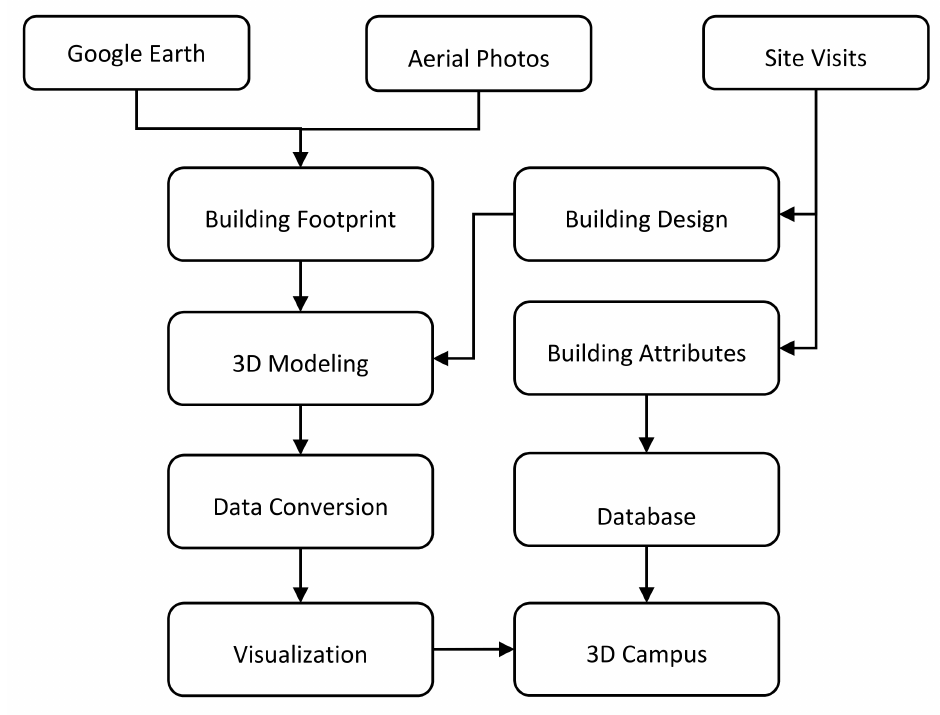
Figure 1. General methodology of virtual 3D campus